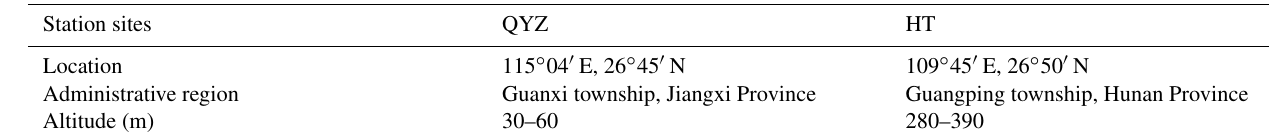
Table 1. Description of QYZ and HT experimental station. Station sites